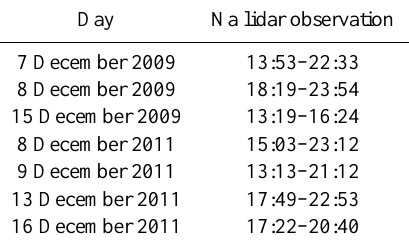
Table 4. Na lidar measurements in December 2009 and 2011. Only days with more than three hours of data are listed. Times are given in [hh:mm] format in UT. Local time is UT plus one hour.